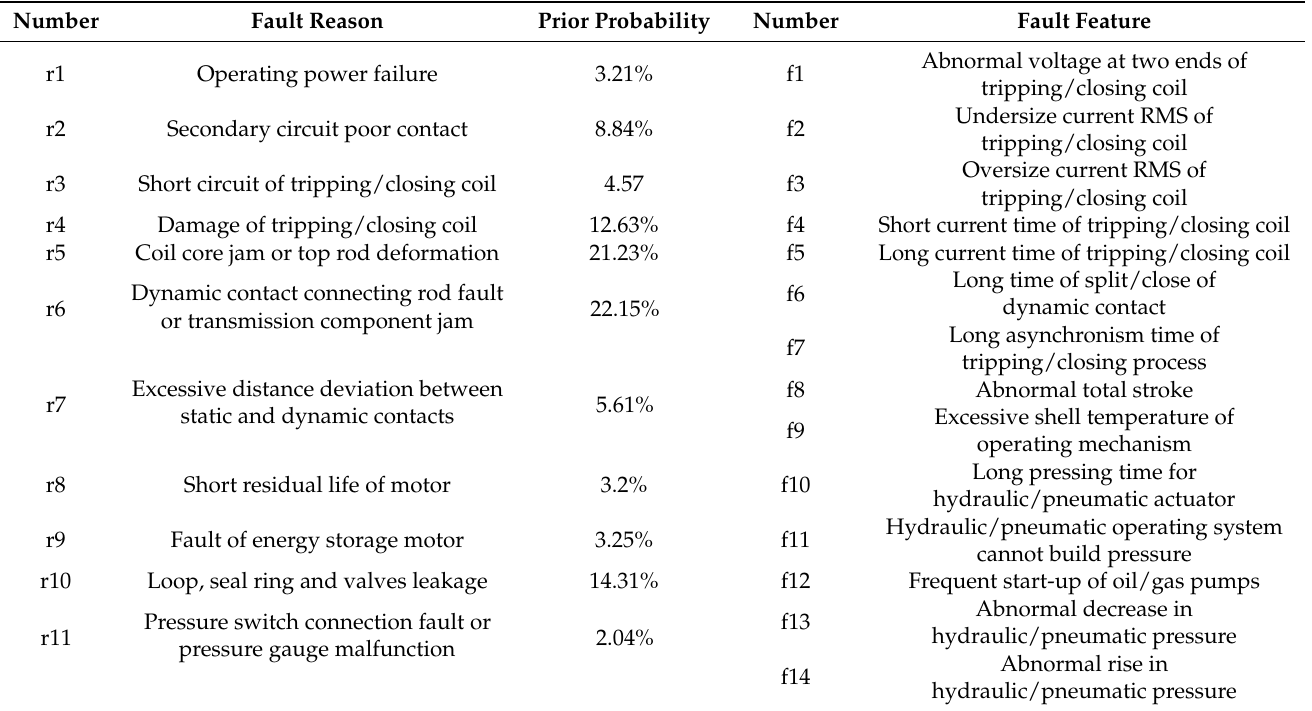
Table 4. Table of partial fault reasons and partial fault features.